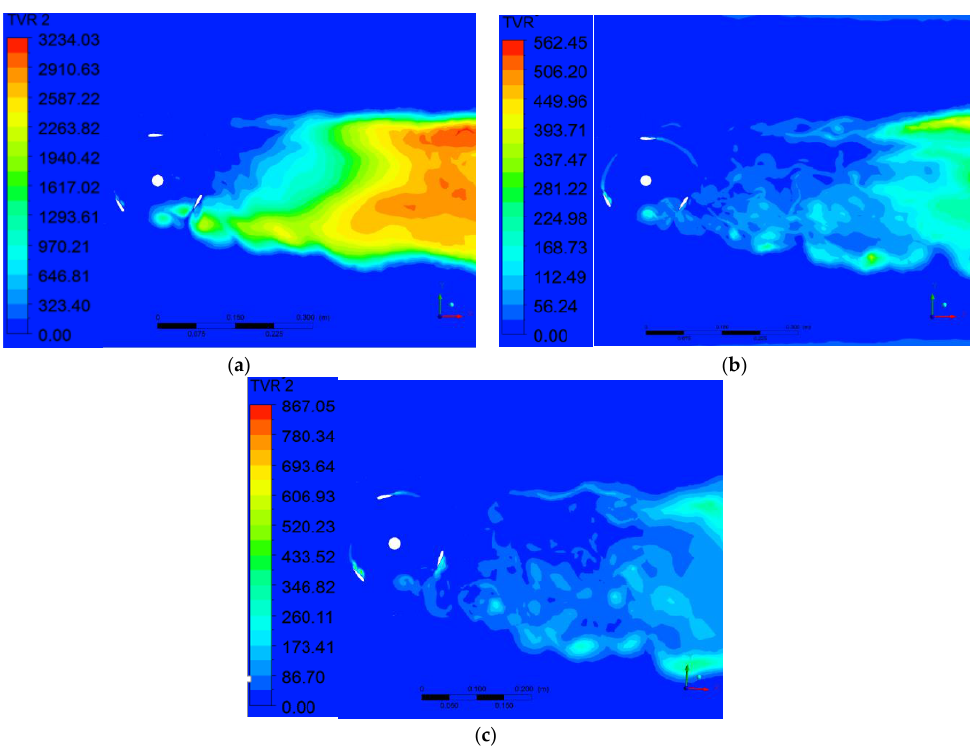
Figure 10. Instantaneous power coefficient for the URANS, DES and DDES model.